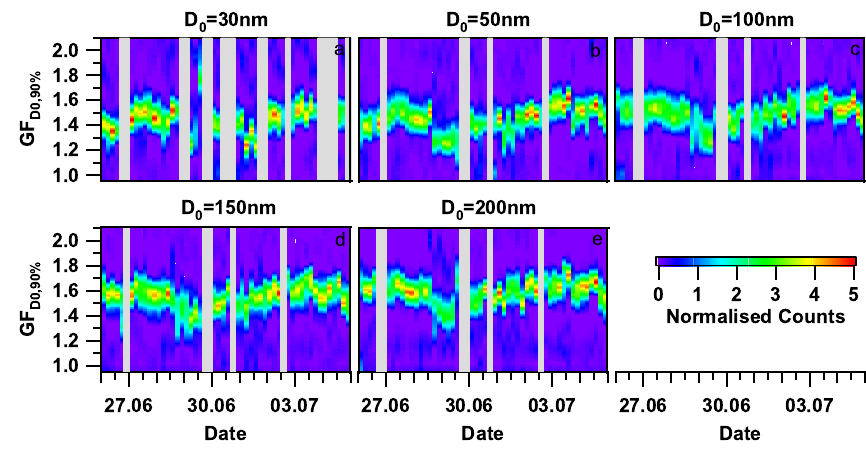
Fig. 12. Time series of the hygroscopic growth factor distributions measured during the MAP campaign, at the 5 set D 0 in panels a to e.